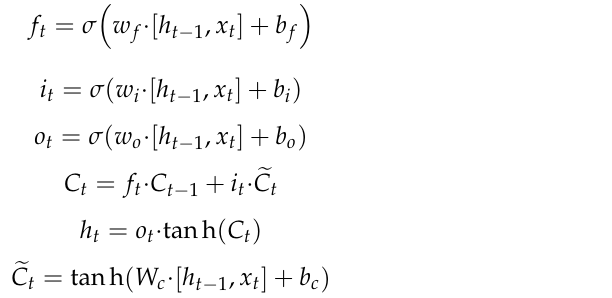
(9) Figure 2. LSTM-FC model structure diagram.